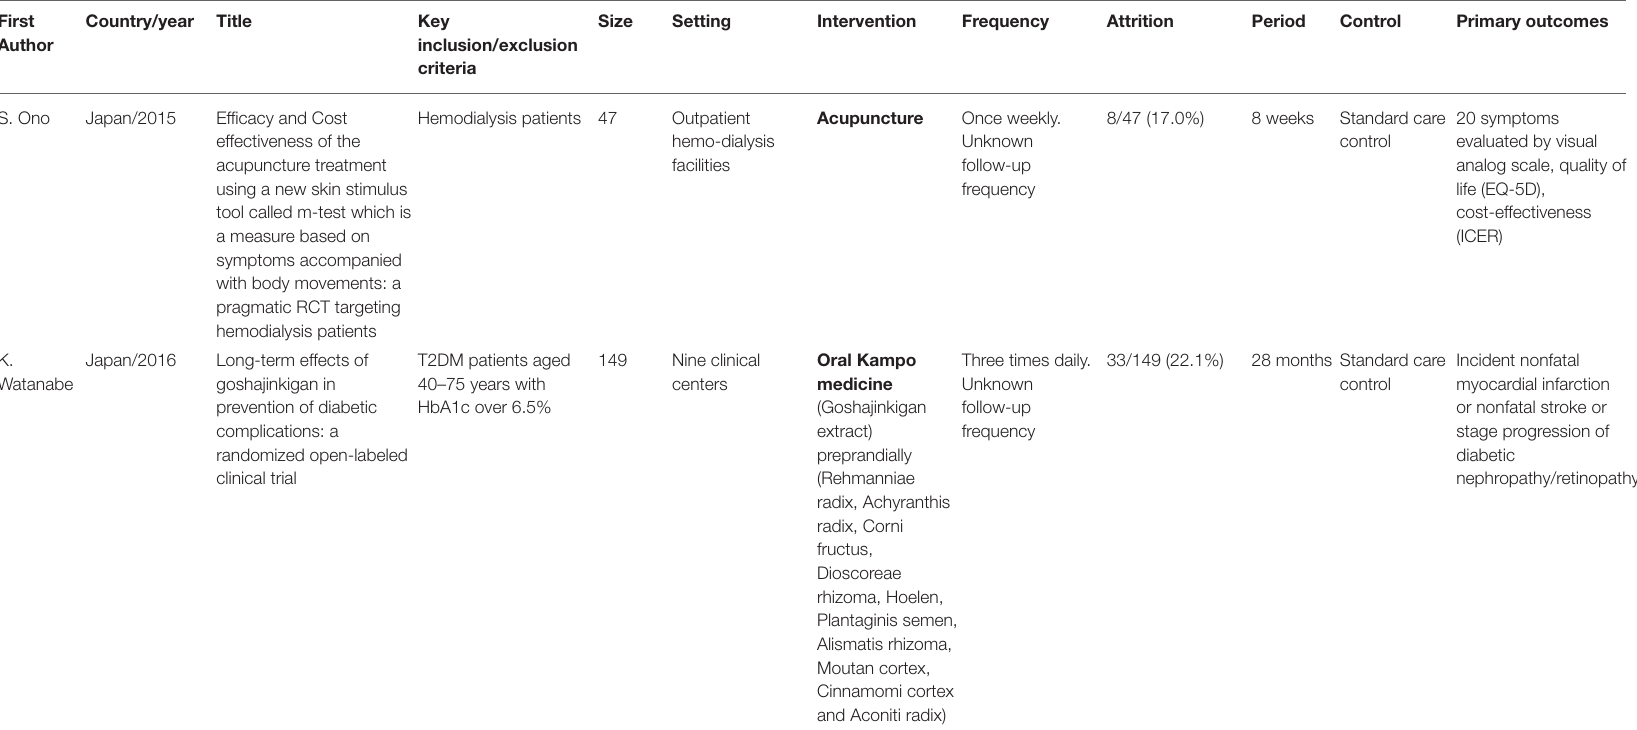
TABLE 2 | Characteristics of included